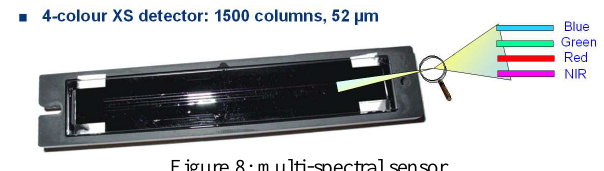
Figure 8: multi-spectral sensor Five sensors of each kind are used simultaneously to obtain a wide field of view (about 20 km). (Fig 9) Image reconstruction at the level of the inter-array areas is one of the tasks of the ground segment.[1]